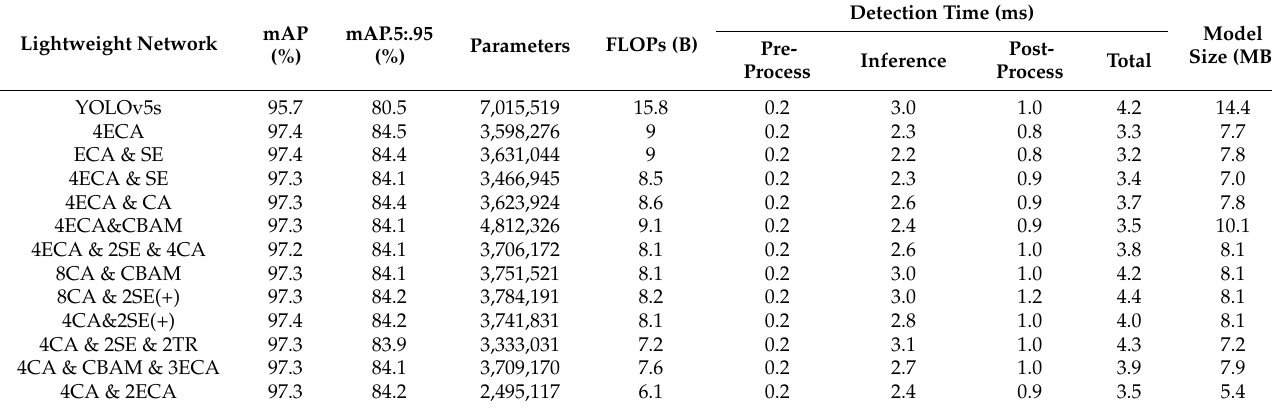
Table 6. The comparison of a lightweight improved network and an original network.